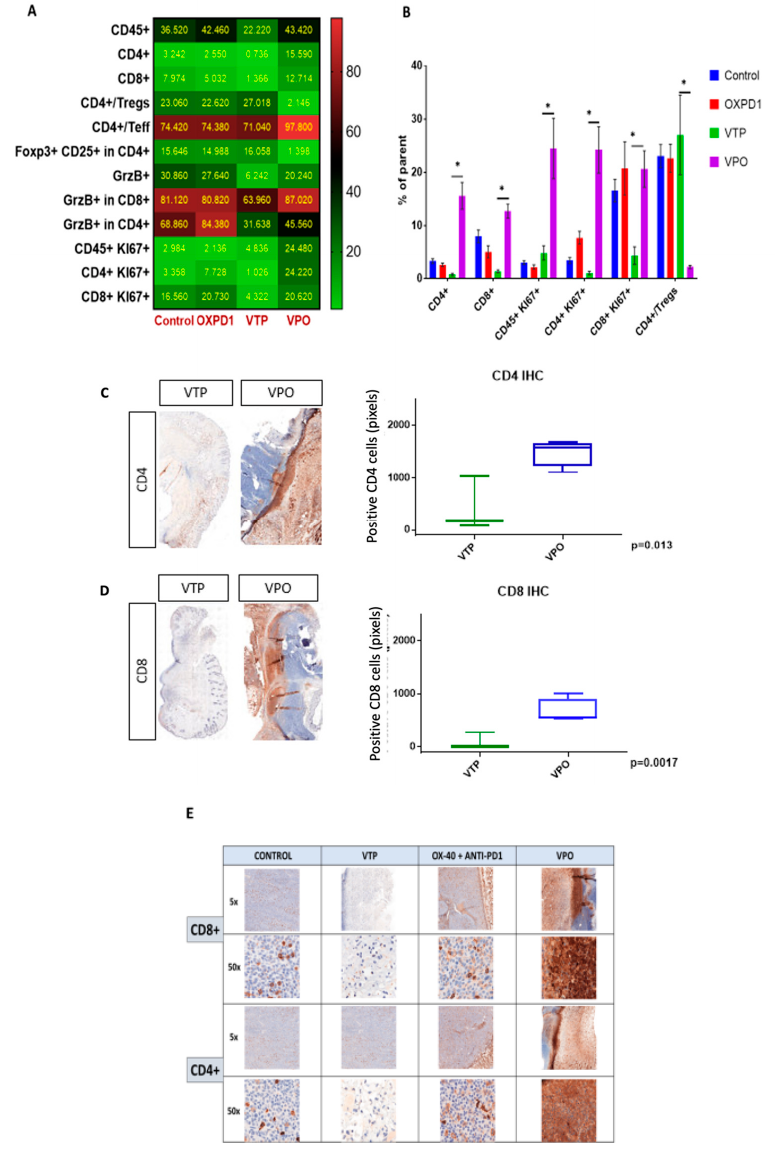
Figure 2. Adding PD-1 inhibitor and OX40 agonist to VTP therapy increases T cell infiltration and activation into MB-49 UTUC allografts at 7 days post-treatment and increases CD4 + and CD8 + T cell infiltration into MB-49 UTUC allografted tumors. ( A ) Heat map showing the mean frequency of each cell population as measured by flow cytometry in control and treated tumors. Each box represents the mean percentage of positive cells among the parent cell population, i.e., CD45 + among live cells, CD4 + or CD8 + cells among CD45 + cells, Foxp3 + Tregs or Teff among CD4 + cells, CD25 + / Foxp3 + Tregs among CD4 + cells, GrzB + among CD45 + cells, GrzB + cells among CD8 + or CD4 + cells, Ki67 + cells among CD45 + cells, and Ki67 + among CD8 + or CD4 + cells. ( B ) Frequency of positive cells among the parent cell population. Graph bars indicate mean ± SEM. * p < 0.01. OXPD1, OX40 agonist plus PD1 inhibitor; VTP+OX40+PD-1, VTP plus PD1 inhibitor and OX40 agonist. ( C ) A representative IHC of CD4 + T lymphocytes in VTP+OX40+PD-1-treated tumors compared with VTP followed by the signal intensity comparison showing a more significant CD4 + staining in VTP+OX40+PD-1 group compared to VTP alone ( p = 0.013). ( D ) A representative IHC of CD8 + T lymphocytes in VTP+OX40+PD-1-treated tumors compared with VTP followed by the signal intensity comparison showing a more significant CD8 + staining in VTP+OX40+PD-1 group compared to VTP alone ( p = 0.0017). ( E ) A representative microscopy IHC illustration of CD8 + T lymphocytes and CD4 + T lymphocytes difference between control, VTP, OX40 plus PD1 and VTP+OX40+PD-1 groups. In both staining, VTP+OX40+PD-1 presented a clear high intensity